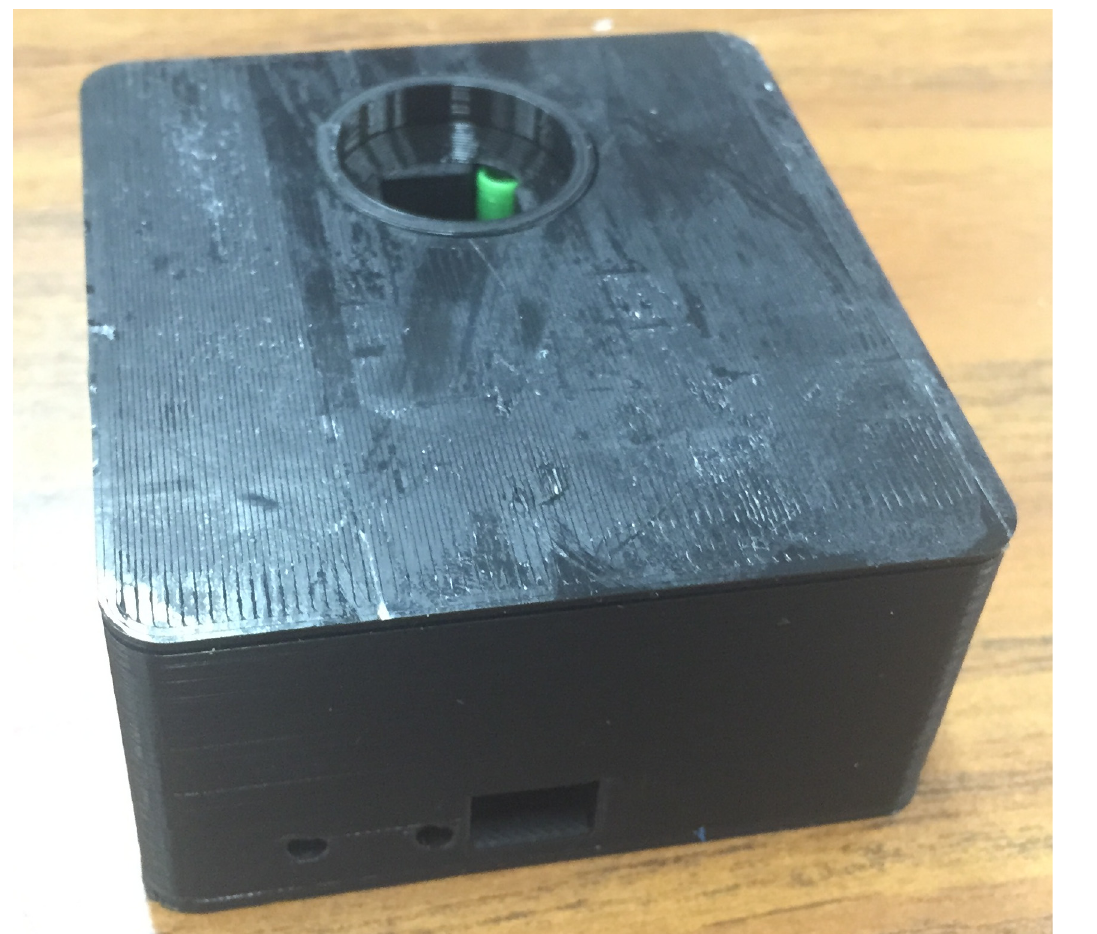
Fig 5. Assembled photometer